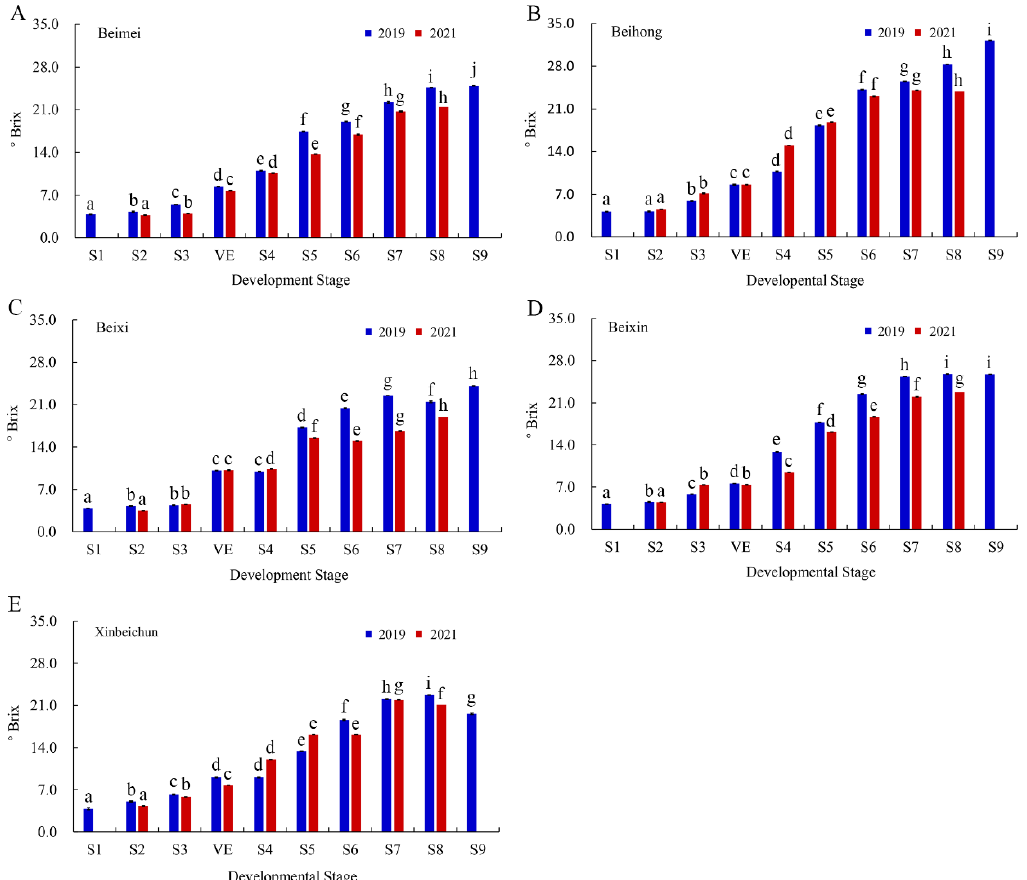
Figure 5. Soluble solid changes of ‘Beimei’ ( A ), ‘Beihong’ ( B ), ‘Beixi’ ( C ), ‘Beixin’ ( D ) and ‘Xinbeichun’ ( E ). S1 sampling date was 19 June 2019. S2 sampling date in 2021 was 8 July. S1–S9 were sampled once every two weeks, VE = veraison. Data are mean values of three replicates. The error bars indicate the SE from repeats. The letters above the bars indicate significant differences ( p < 0.01, determined by one-way ANOVA).